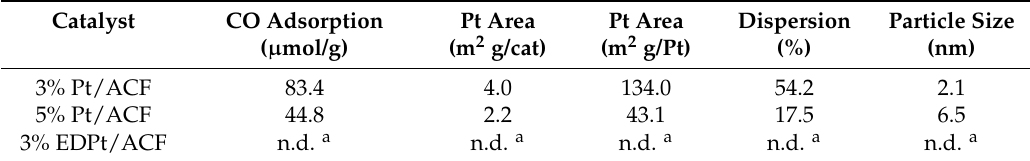
Table 2. CO adsorption properties and dispersion of Pt.